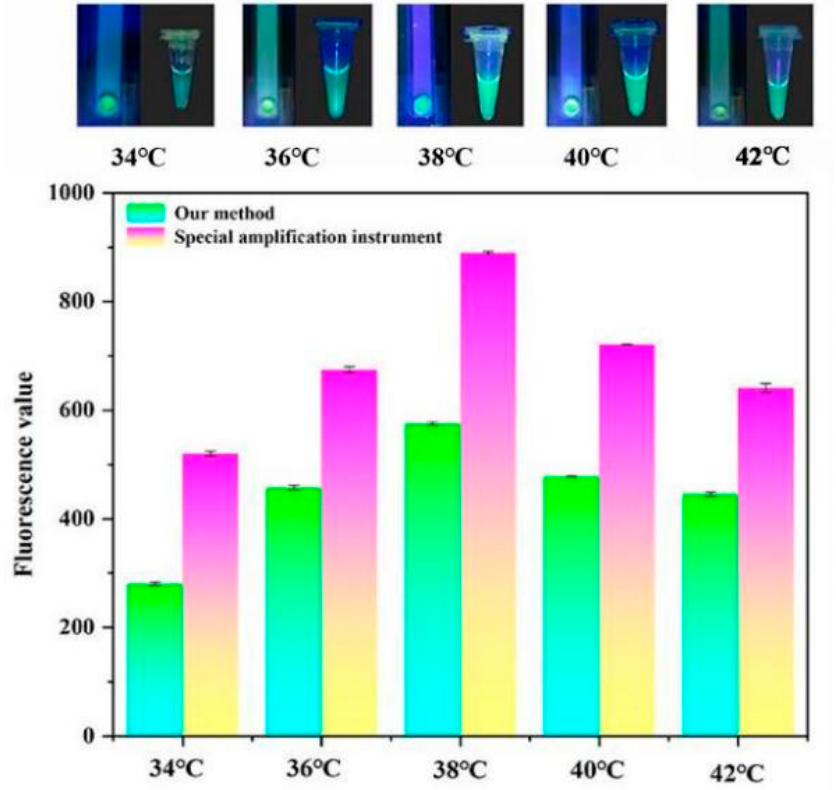
Figure 4. Evaluation of SMART temperature control performance. Visual detection results of the SMART ( top panel ); end point fluorescence value of visual detection results of target genes ( bottom panel ).